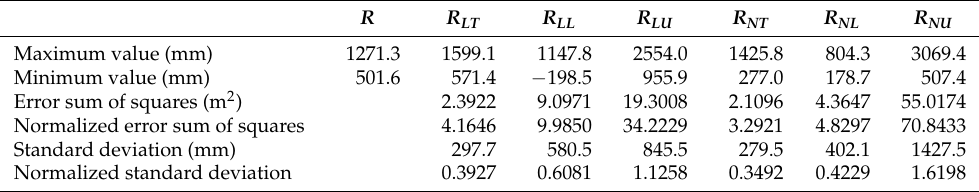
Figure 13. Prediction of rainfall distribution by nonlinear analysis of 149 LSL potential areas. Table 8. Statistics of rainfall predictions for 28 occurrence-time-known LSL cases.